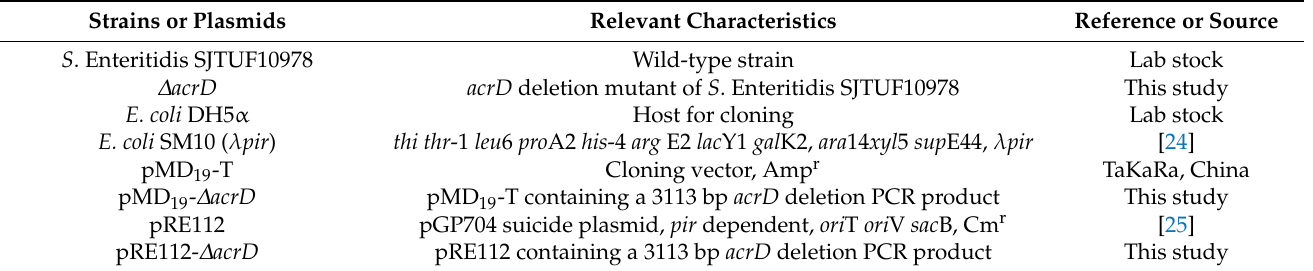
Table 2. Strains and plasmids used in this